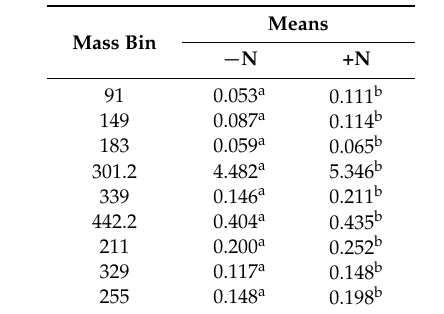
Figure 3. Principal component analysis: PC 1 vs. PC 2 of Malevo and Guerrero. ( a ) Block effect; and ( b ) N effect. Table 3. Mass bins responding to fertiliser levels in ANOVAs applied to quality